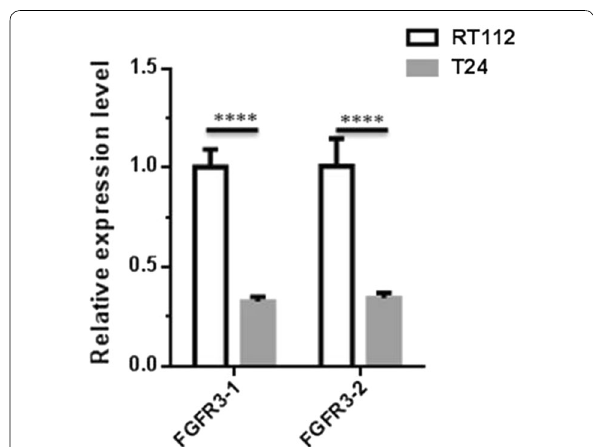
Fig. 6 The expression level of FGFR3 in RT112 and T24 cells. The total RNA of RT112 and T24 cells was extracted, respectively. The reverse transcription was performed according to the kit protocol, and PCR was done with two pair of primers against different regions of FGFR3 according to the descriptions of “Materials and methods”. The result showed that FGFR3 both expressed in RT112 and T24 cells, but the expression level of FGFR3 in RT112 cells is threefold higher than that of in T24 cells. P < 0.0001, n =